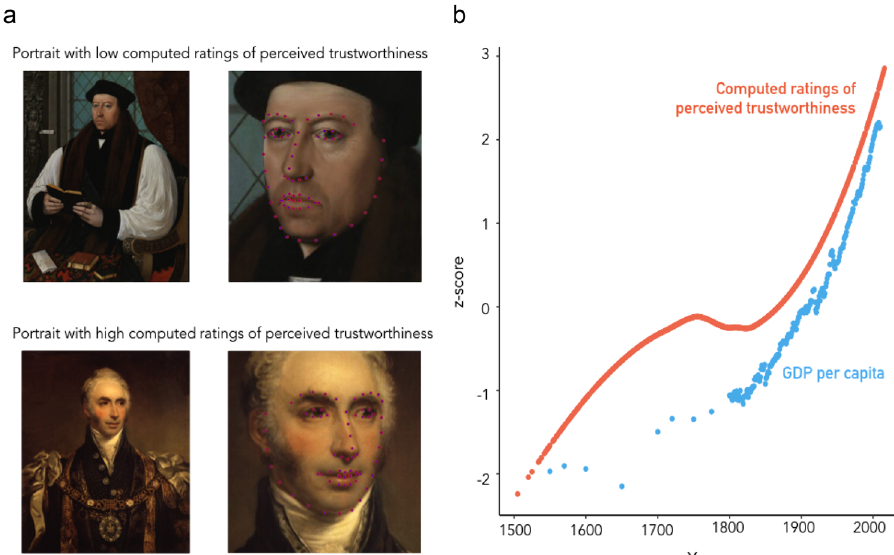
Fig. 1 Evolution of ratings of perceived trustworthiness in England across time. a Example of faces detected in portraits from the National Portrait Gallery and estimated as being perceived as lowly trustworthy (top; Thomas Cranmer by Gerlach Flicke, 1545-1546, NPG 535 All rights reserved © National Portrait Gallery, London) and estimated as being perceived as highly trustworthy (bottom; Sir Matthew Wood by Arthur William Devis, 1815-1816, NPG 1481 All rights reserved © National Portrait Gallery). b Evolution of ratings of perceived trustworthiness in the National Portrait Gallery (for representation purposes, in this Figure, evaluations of perceived trustworthiness were fi tted by a local polynomial regression with a span of 0.75 and adjusted for perceived dominance) and GDP per capita in England. (log-transformed for representation purposes). Source data are provided as raw data and scripts on the online